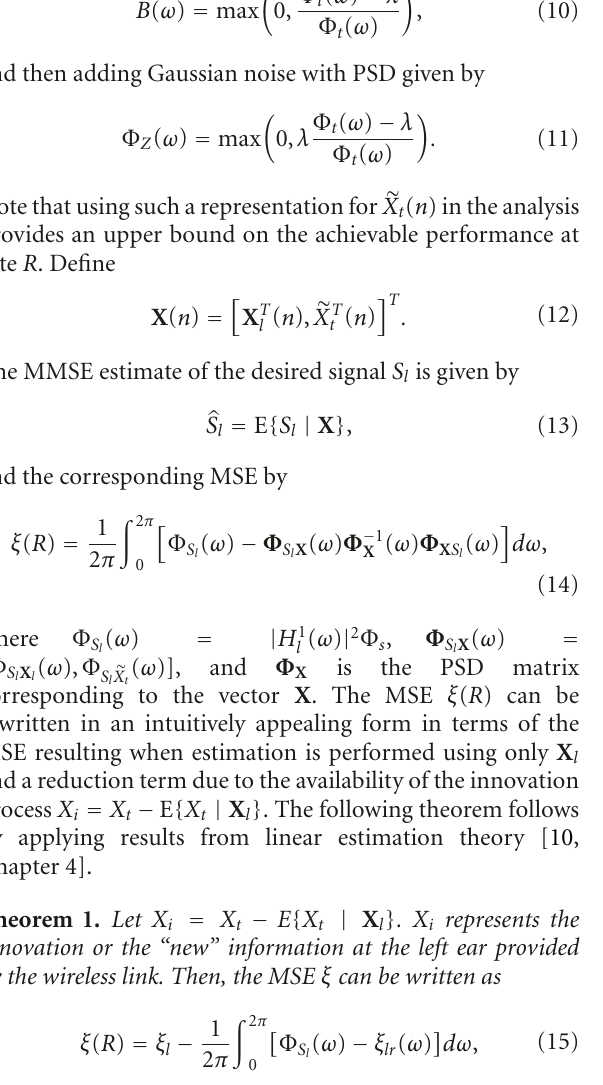
Figure 3 using the forward channel representation [9]. The signal (cid:13) X t ( n ) is obtained by first bandlimiting X t ( n ) with a filter with frequency